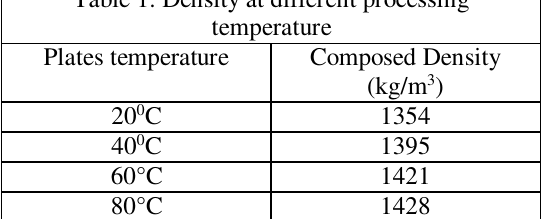
Table 1: Density at different